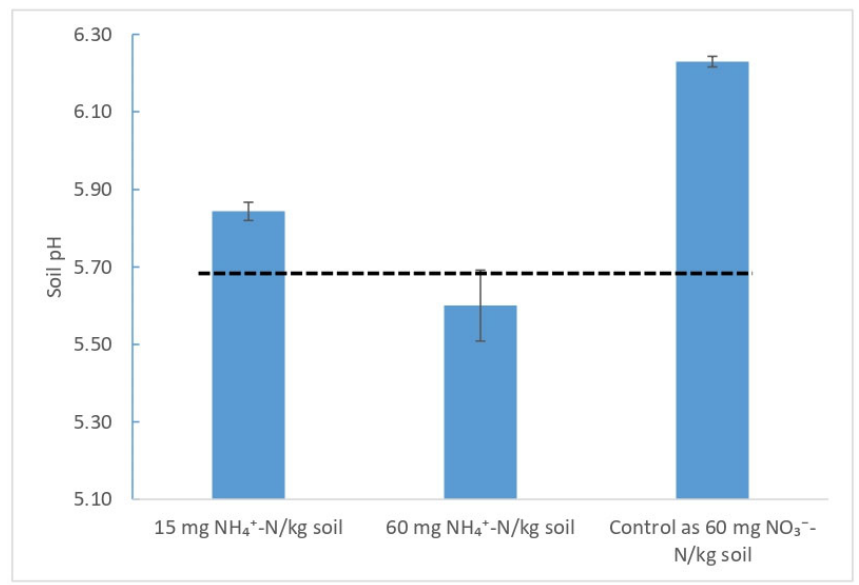
Figure 7. Effects of the NH 4+ -N treatments on for the rhizosphere soil pH. The dotted line represents the starting soil pH before any treatment was applied. Means ± SE (n = 3).